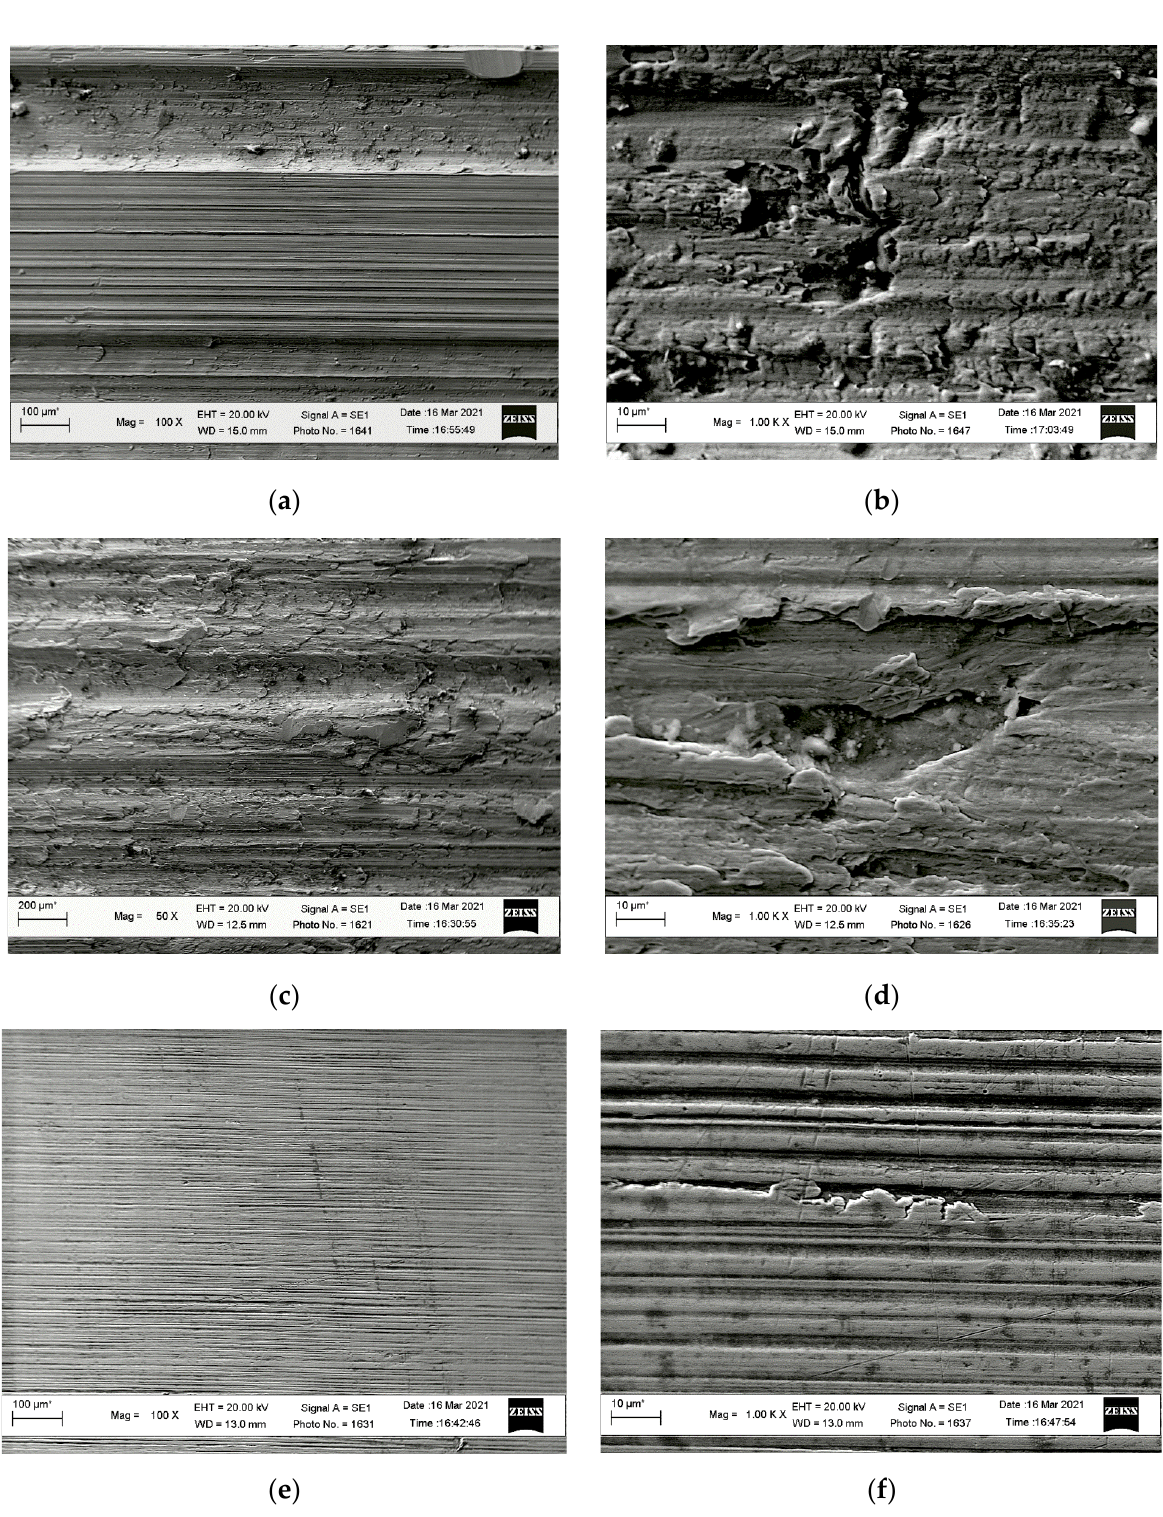
Figure 3. Images of specimen surfaces at 100 × magnification: ( a , b )—after roughing; ( c , d )—after semi-finishing; ( e , f )—after finishing.